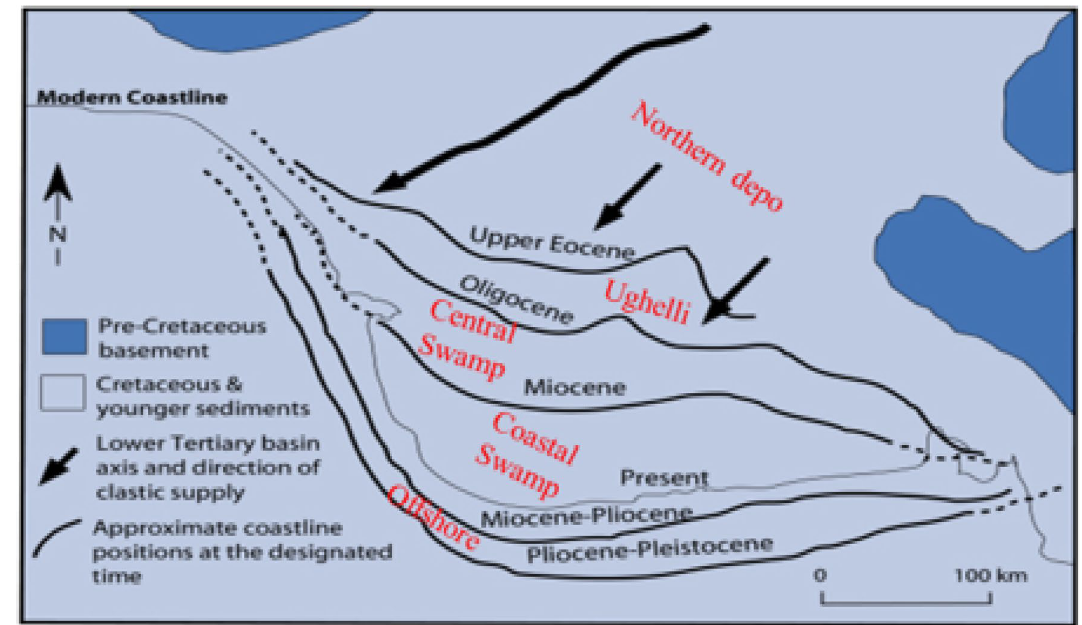
Fig. 2 Depobelts and direction of sediment deposition in Niger delta (Tuttle et al. 1999)